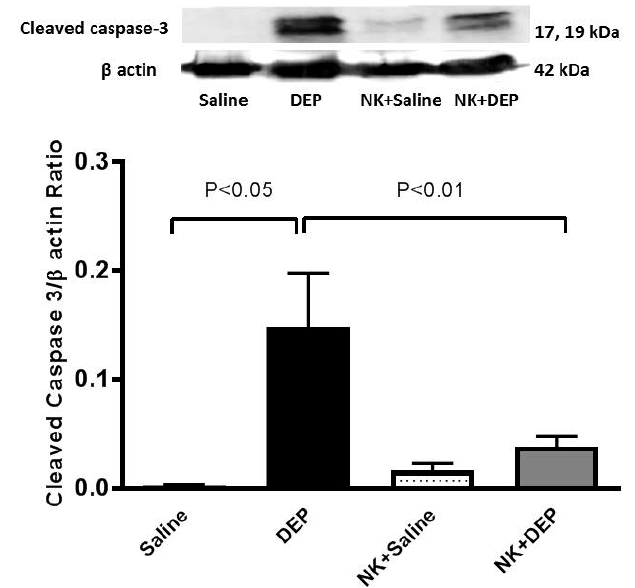
Figure 6. Cleaved caspase-3 levels in the lung tissues determined by Western blotting, 24 h after intratracheal instillation of either saline or diesel exhaust particles (DEP, 30 µg/animal), with or without nootkatone (NK) pretreatment. Data are mean ± SEM ( n = 4 in each group).